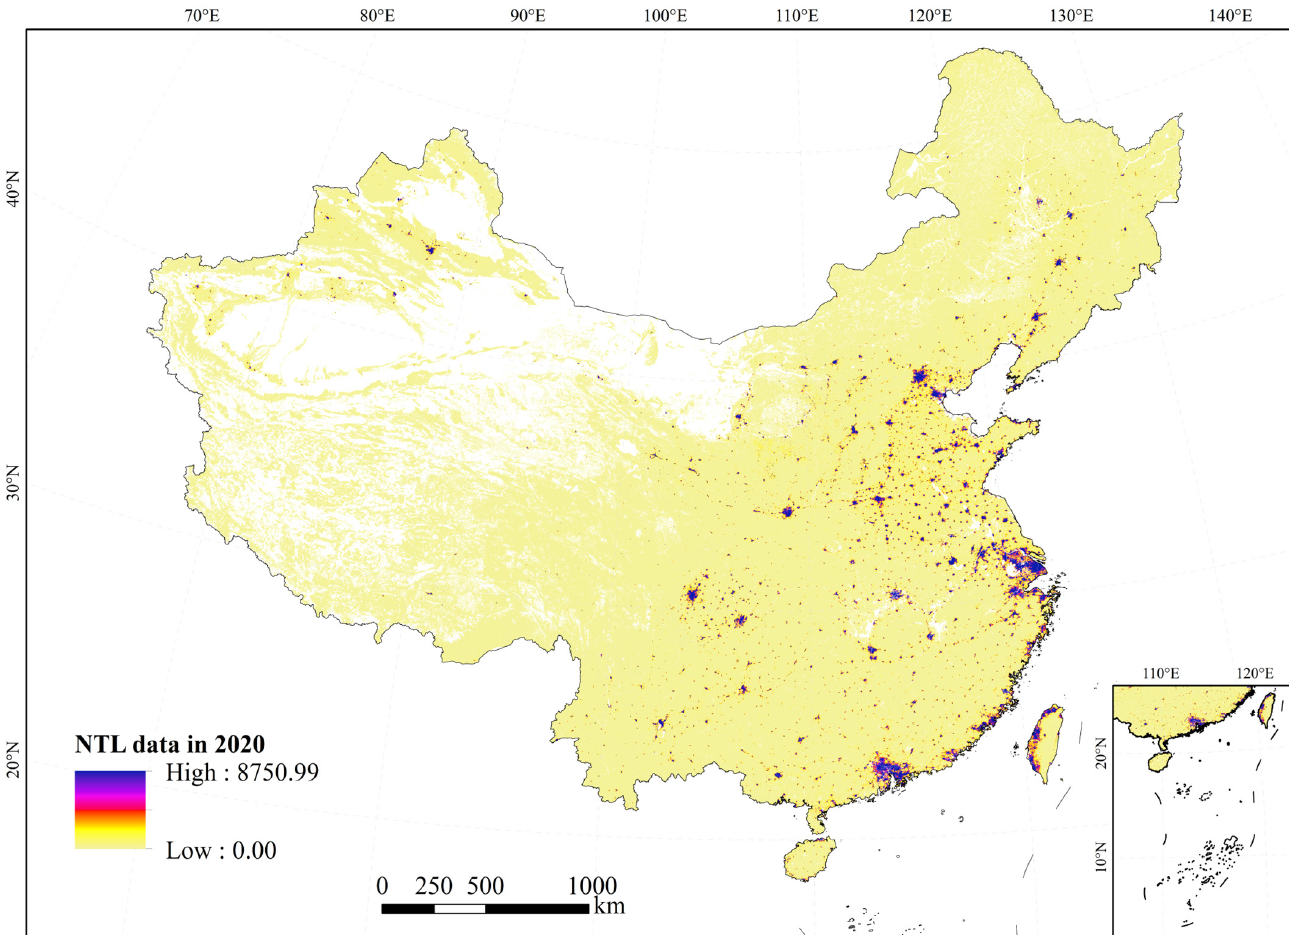
Figure 2. NTL image data for 2020 (from SNPP-VIIRS). Water bodies and unused land have been removed.